Question: Produce a descriptive caption suitable for publication.
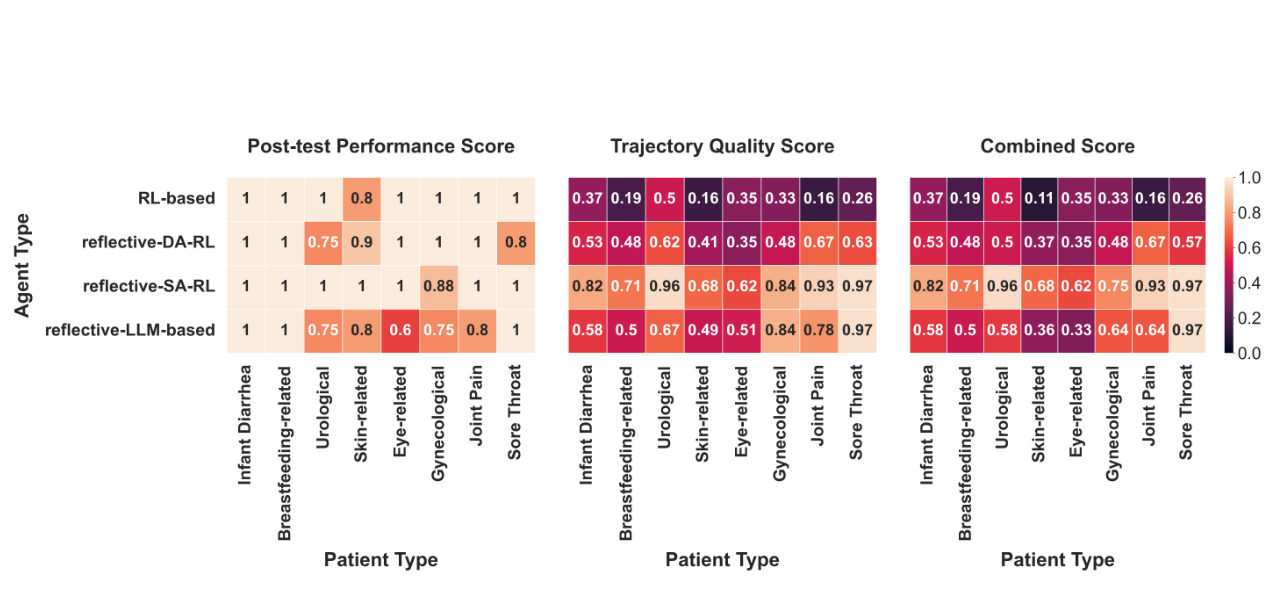
Answer: Performance of different agents in interaction with different patients. Post-test Performance Score (left), Trajectory Quality Score (middle), and Combined Score (right) for RL-based and reflective SA-RL, DA-RL, and LLM-based agents.